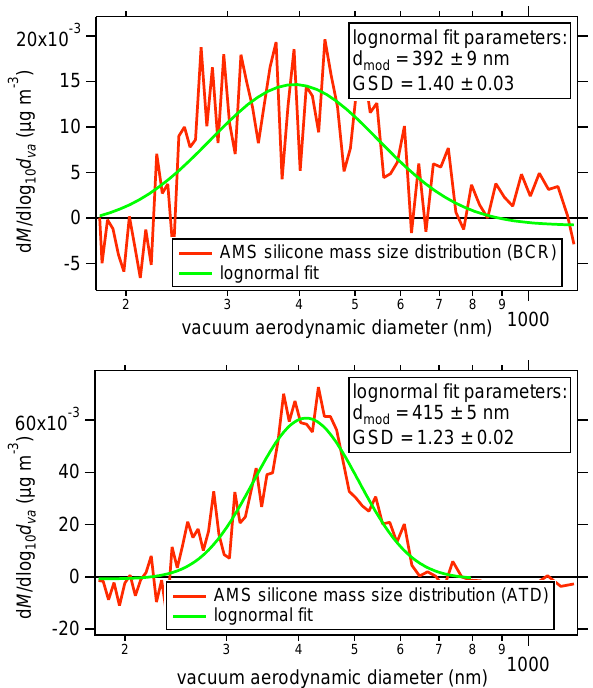
Fig. A2. Silicone size distributions for 200nm mobility diameter particles with log normal fit. Upper graph: BCR, averaged over 1h and 20min lower graph: ATD, averaged over 5h and